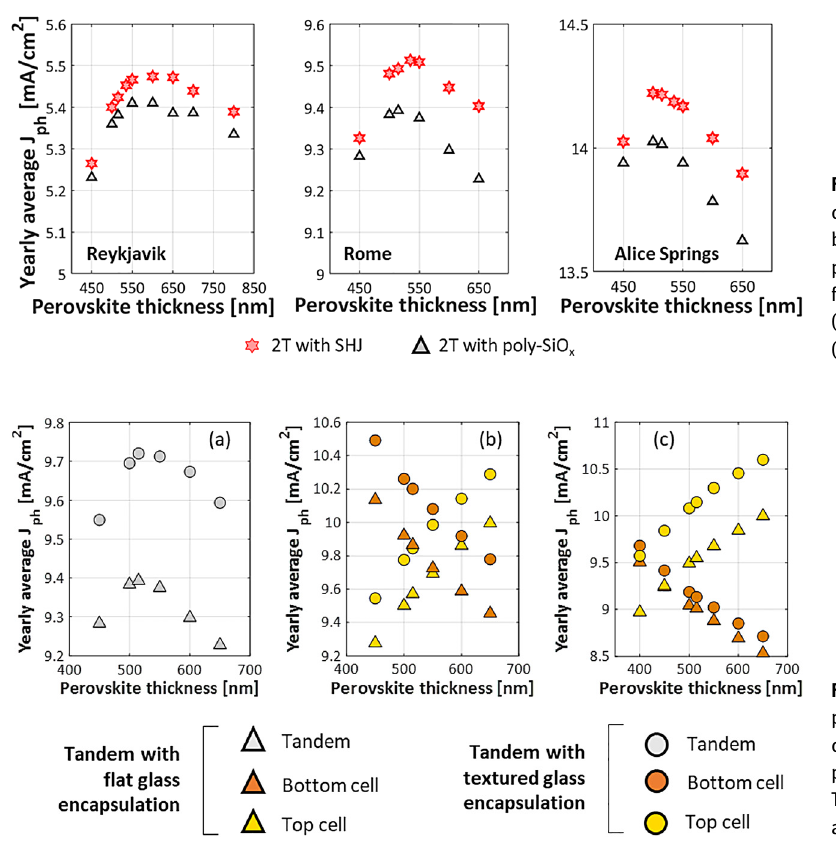
Figure 7: Simulated yearly average photocurrent density of mono-facial tan- dems with poly-SiO x bottom cell for varying perovskite absorber thickness in Rome. The tandem configurations are (a) 2T, (b) 3T and (c)